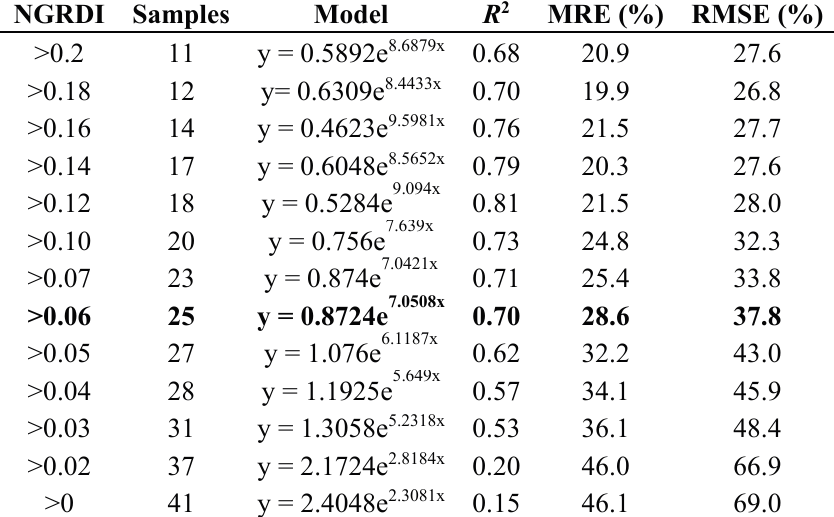
Figure 4. Relationship between normalized green-red difference index (NGRDI = (R rs , 560 − R rs , 681 )/(R rs , 560 + R rs , 681 )) and Chl-a concentration. Although no correlation was found for sediment-rich (TSS ~> 25 mg·L − 1 ) waters, a positive correlation exists between Chl-a and NGRDI in relatively sediment-poor waters. The dashed blue line indicates the lower limit of the NGRDI, where the NGRDI-based Chl-a algorithm can be used. Table 1. Chl-a algorithms at different NGRDI levels (0–0.2) based on in situ R rs and Chl-a measurements. Their associated performances are also listed. The bolded line represents a compromise between algorithm accuracy and data coverage and is therefore selected as the model in this study (NGRDI > 0.06) to apply to the entire MERIS